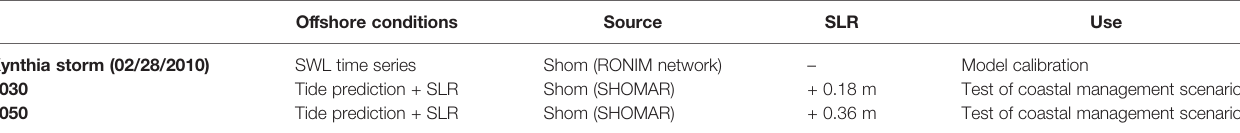
TABLE 1 | Summary of offshore conditions presented in the paper.